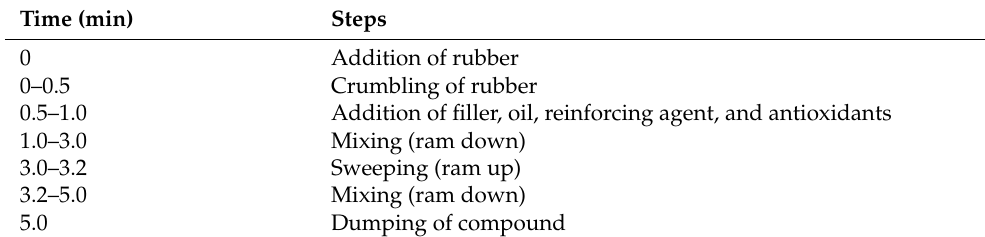
Table 1. Mixing parameters for the EPDM compounds.